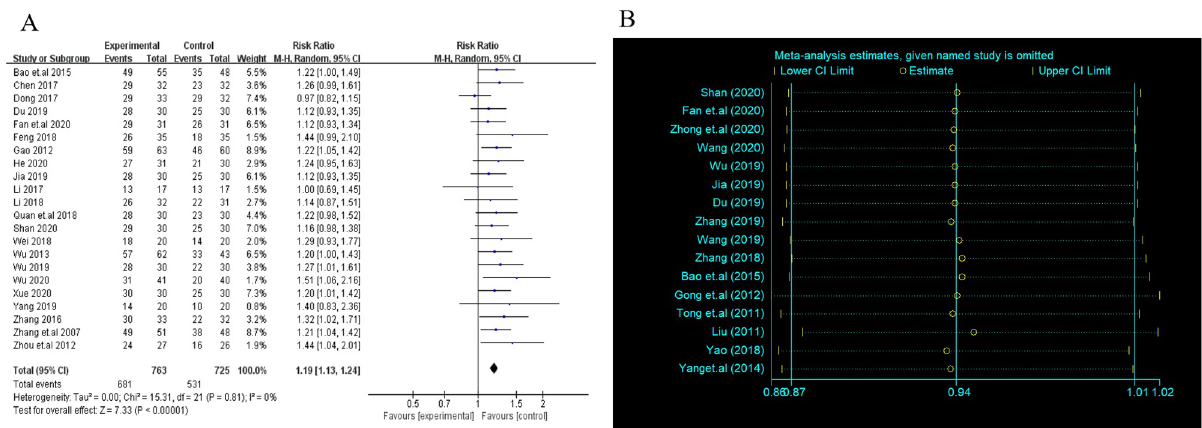
Fig 5. Heterogeneity analysis and sensitivity analysis. (A) Heterogeneity analysis of clinical response; (B) Sensitivity analysis of clinical response. CI: Confidence interval; OR: Odd